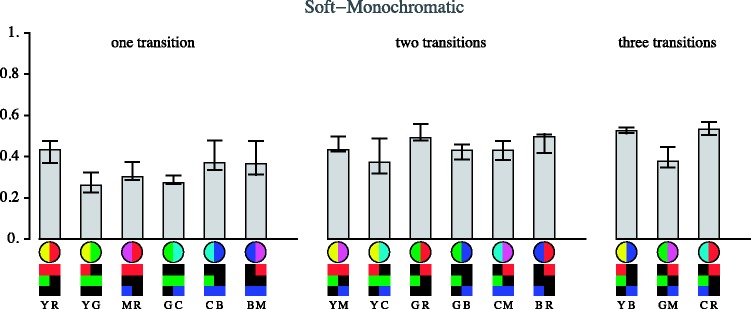
Normalised data for the soft monochromatic condition as quartiles over observers as bar plots for the various colour pairs. The transition structures are illustrated in Figures B1 and B2. The bars show quartile values of the distinctiveness settings for all observers.